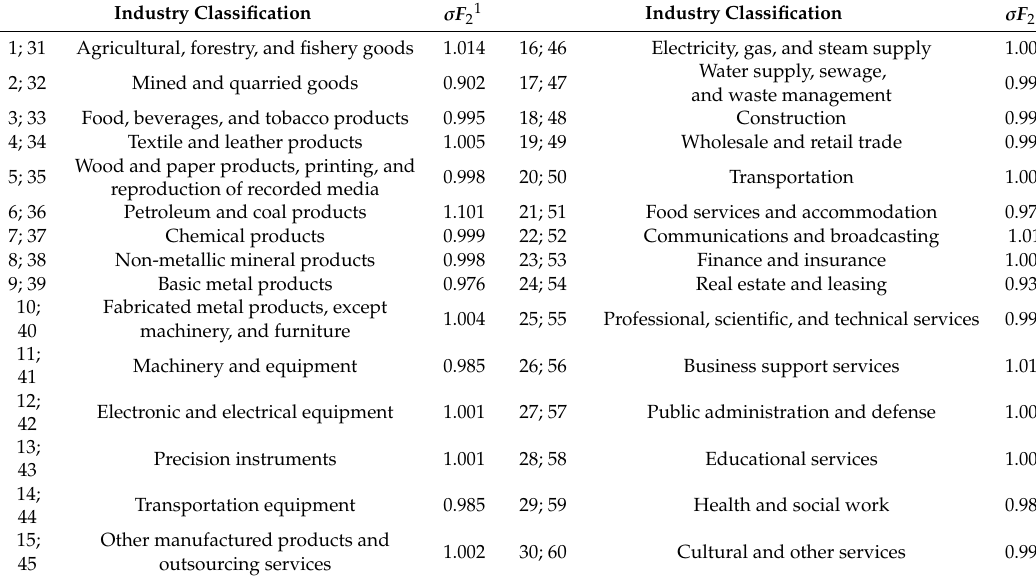
Table 1. Industry classification, modified from